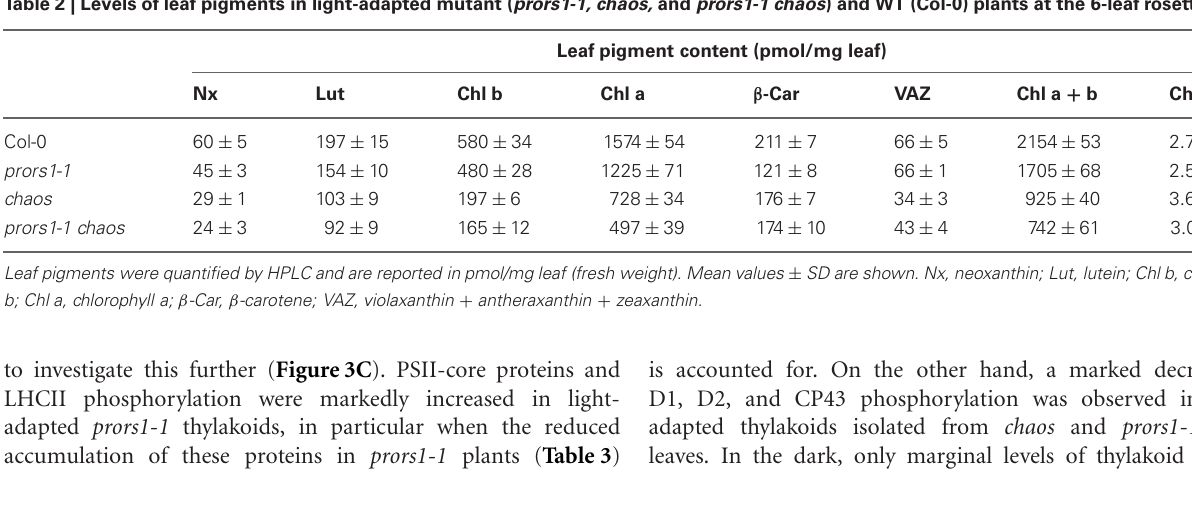
FIGURE 2 | Photosynthetic performance of mutant ( prors1-1 , chaos, and prors1-1 chaos ) and WT (Col-0) plants. The photosynthetic parameters F V / F M (A) and (cid:2) II (B) were measured in the different genotypes, by employing an imaging Chl fluorometer, as described in “Materials and Methods.” Signal intensities for F V / F M and (cid:2) II are Table 2 | Levels of leaf pigments in light-adapted mutant ( prors1-1, chaos, and prors1-1 chaos ) and WT (Col-0) plants at the 6-leaf rosette stage.